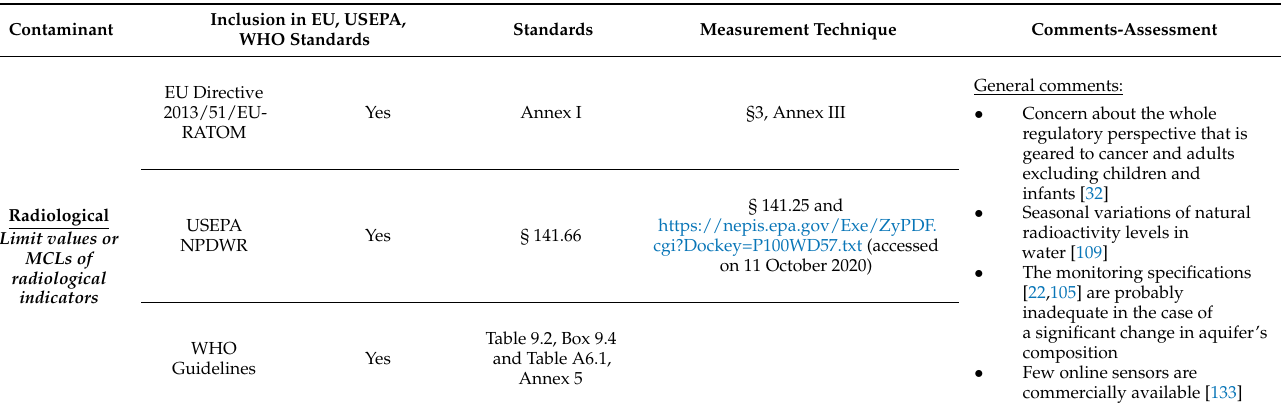
Table 9.2, Box 9.4 and Table A6.1,